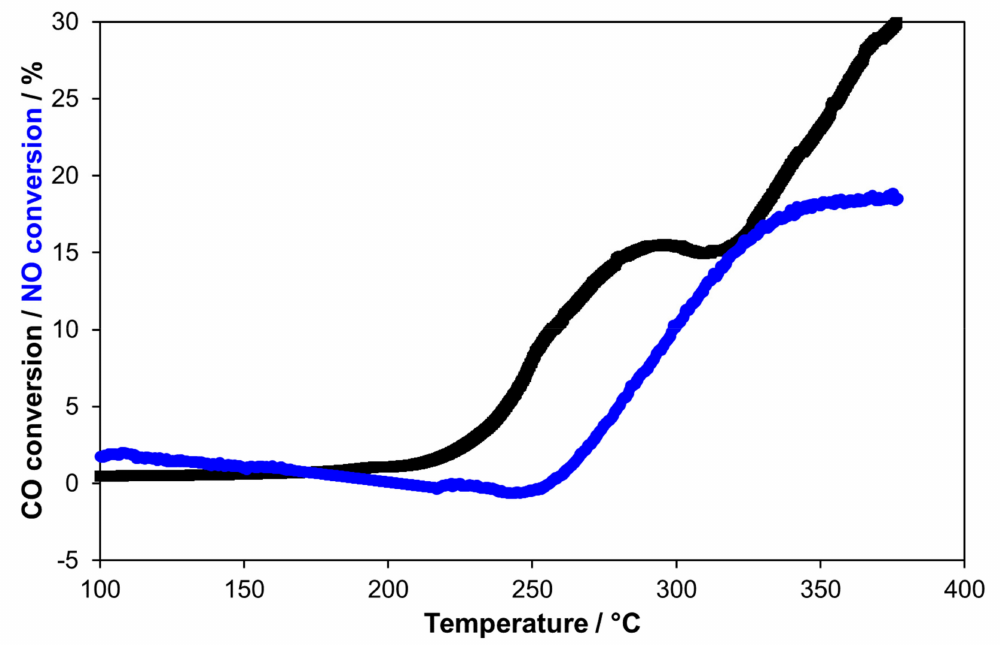
Figure 11. Variation of CO and NO conversion as a function of temperature on LSACO-4.